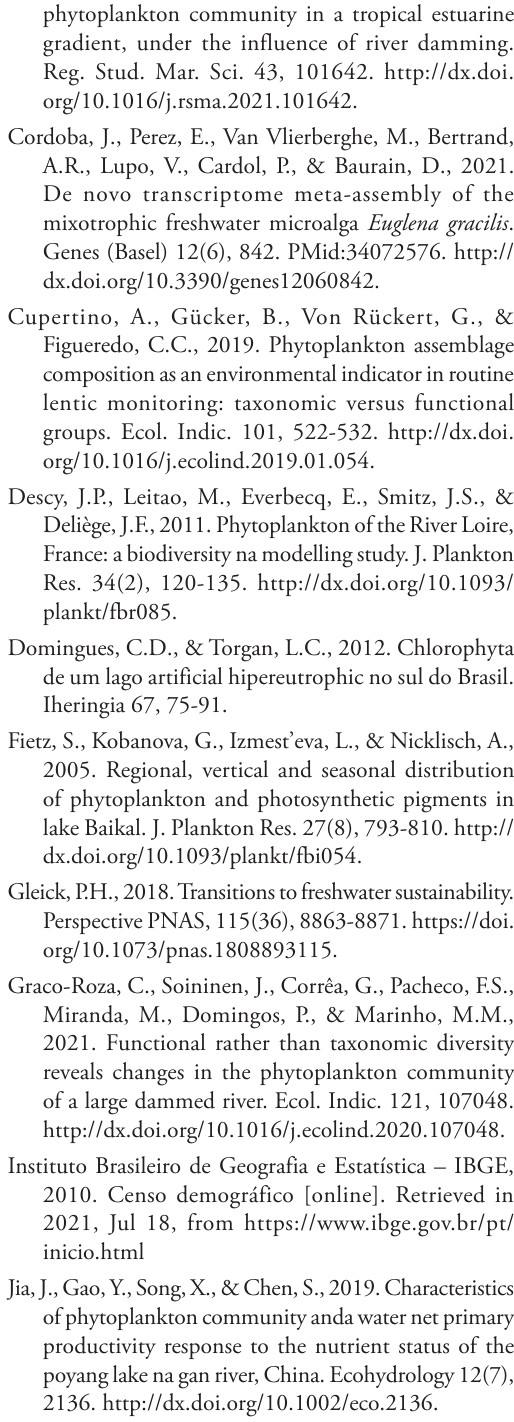
Figueredo, C.C., 2019. Phytoplankton